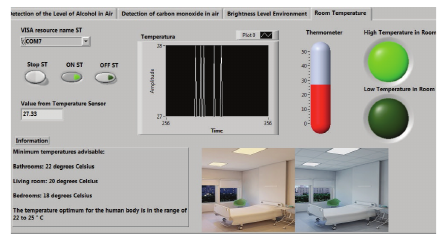
Figure 24: Room temperature profile in MCT [14].